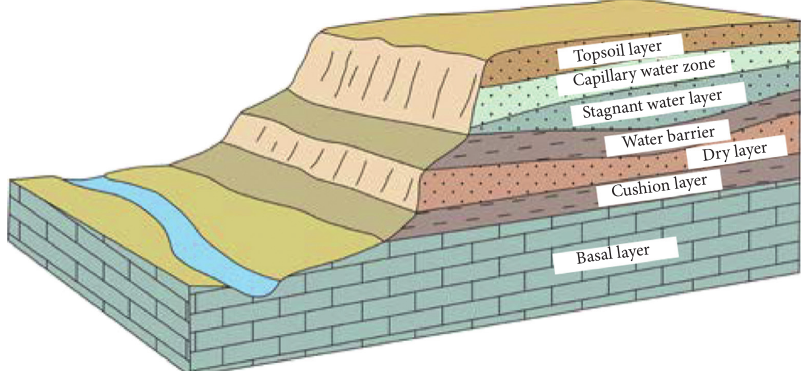
Figure 1: Schematic diagram of aquiclude reconstruction of the external